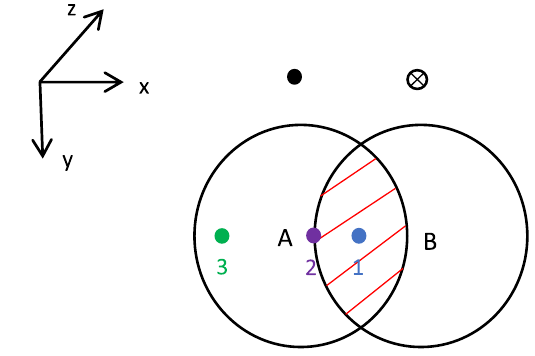
Fig. 4 Illustration of quark scatterings at different